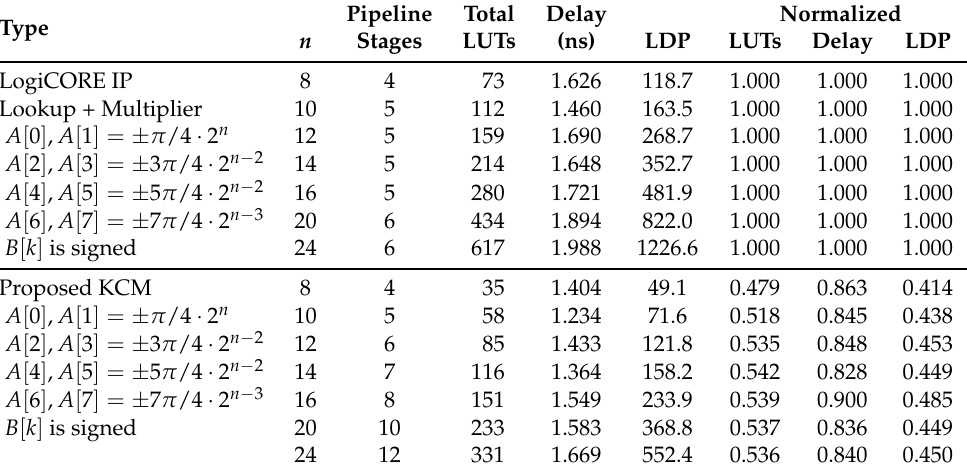
Table 12. Synthesis results for pipelined ( m × n )-bit KCMs with eight selectable coefficients